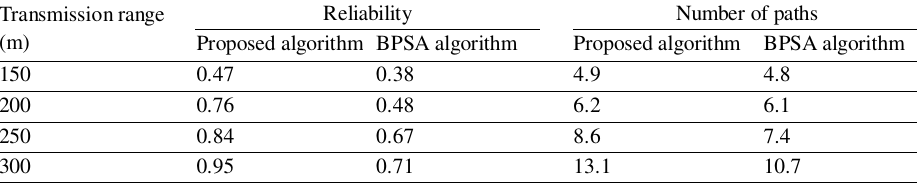
Table 7. Performance comparison between proposed algorithm and BPSA